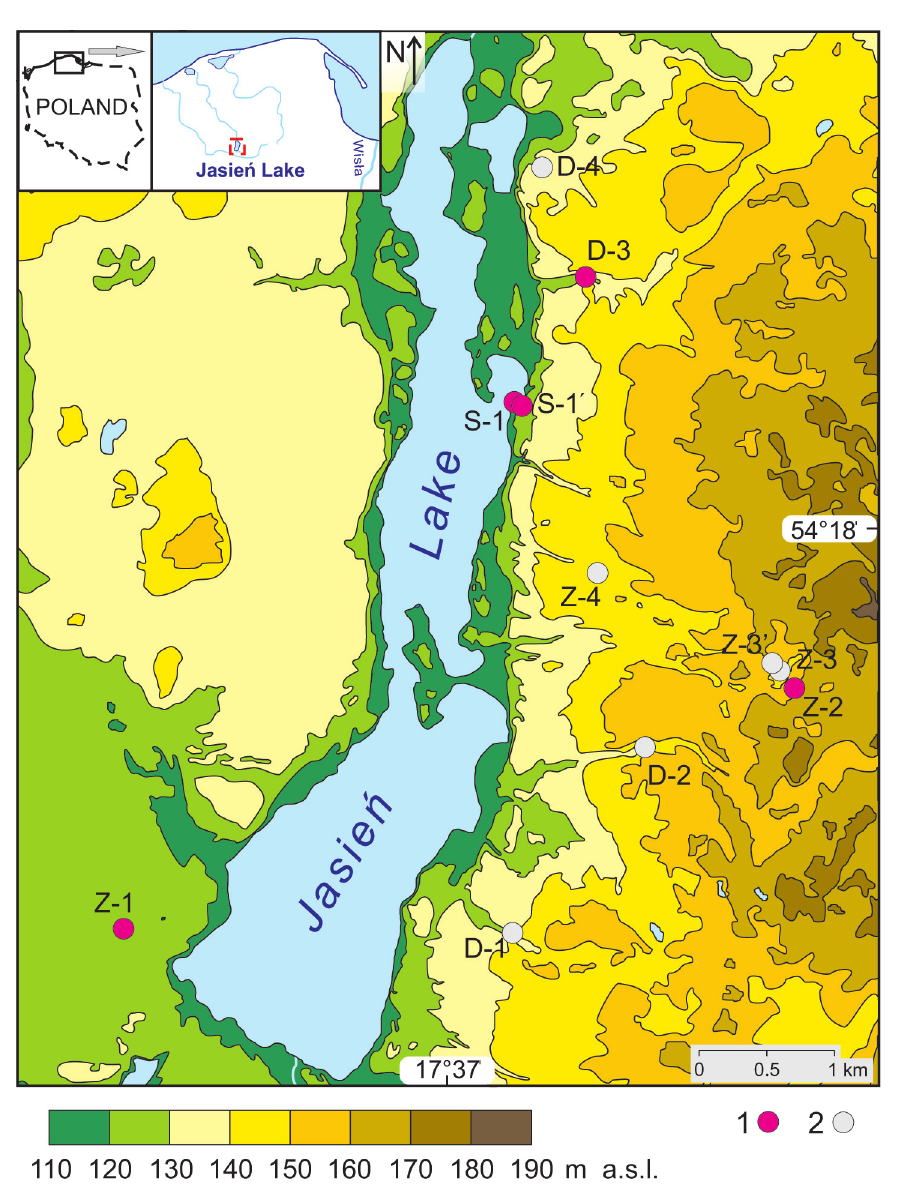
Fig. 1. Sketch of the research area with the location of sites with dated sediments: (1) 5th–9th centuries period; (2) 12th–17th centuries period.